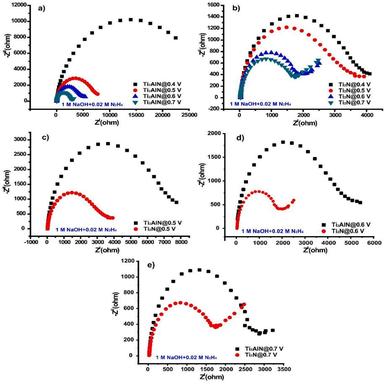
EIS profiles of a) Ti2AlN and b) Ti2NTx at varying potential. Comparison of Ti2AlN and Ti2N at c) 0.5 V, d) 0.6 V, and e) 0.7 V potential in 1 M NaOH+0.02 M N2H4.